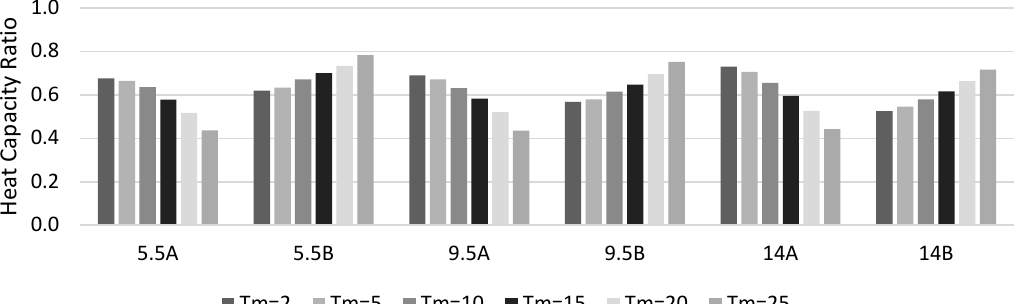
Figure 9. Heat capacity ratios for all simulated cases for heat exchanger 3.